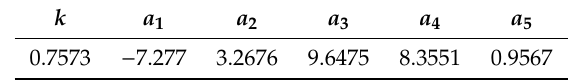
Table 3. Parameters of the empirical formula.